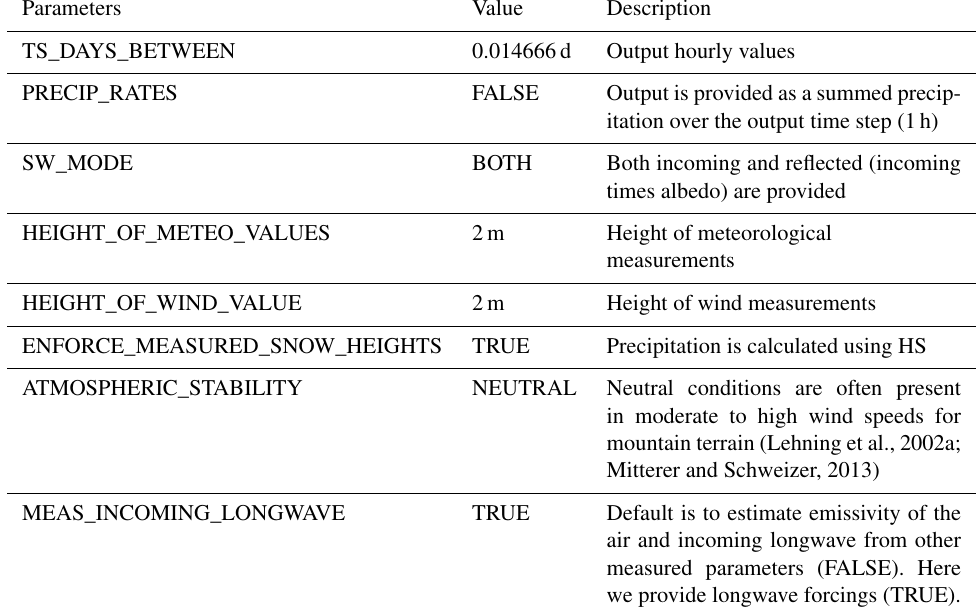
Table A2. Model parameters for